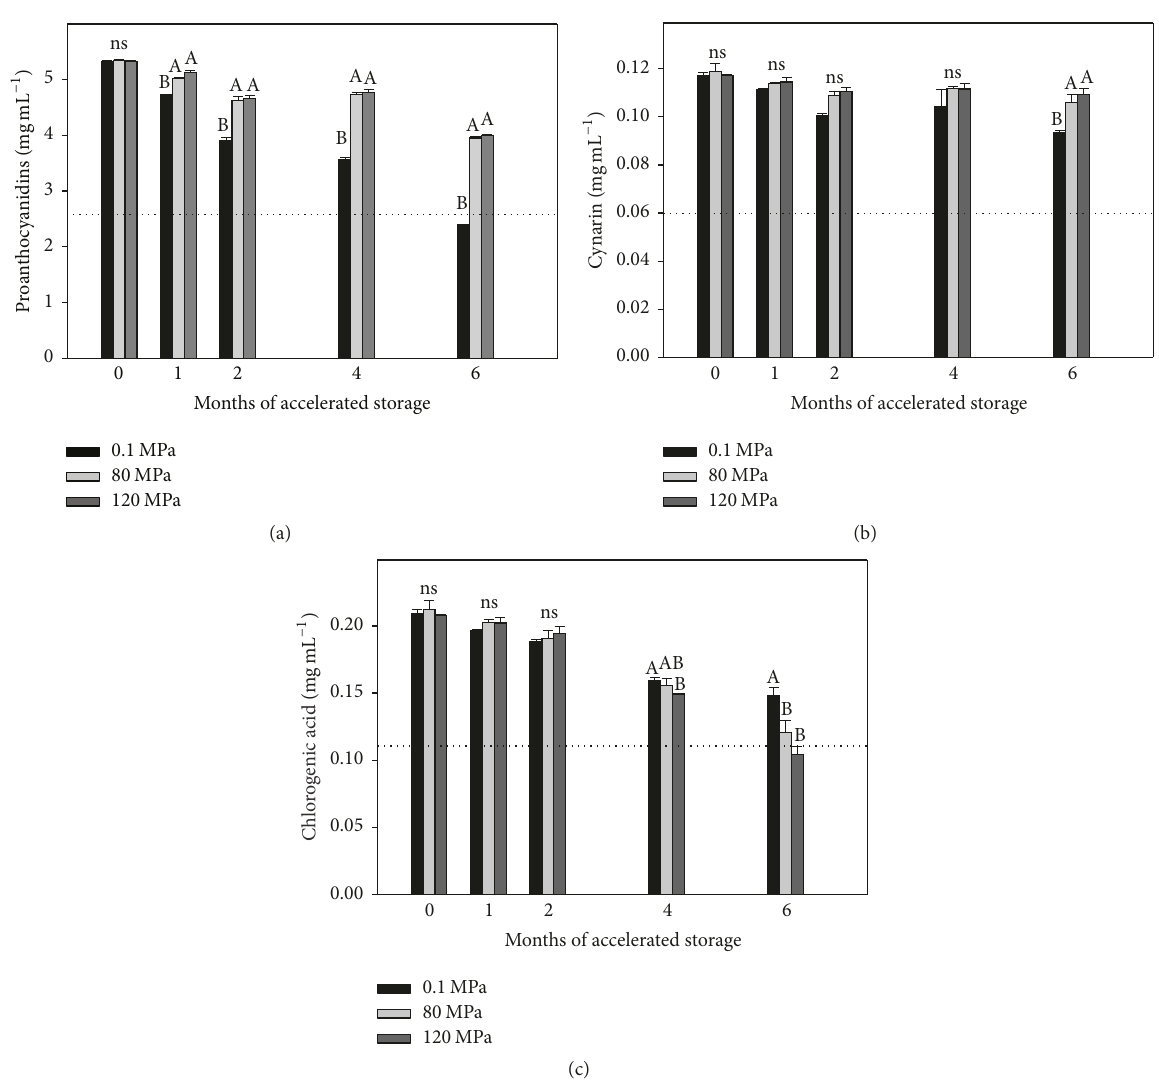
Figure 5: Effect of HPH treatments on the phenol content of cranberry (a) and artichoke food supplements (b, c) stored at 40 ∘ C ± 2 ∘ C and 75% ± 5% RH. Mean ( 𝑛 = 3 ± SD). Different letters within the same day indicate significant differences between pasteurization and HPH treatments at 𝑝 ≤ 0.05 . ns: not significant. The dotted line indicates 50% phenolic losses with respect to the initial contents shown in Table